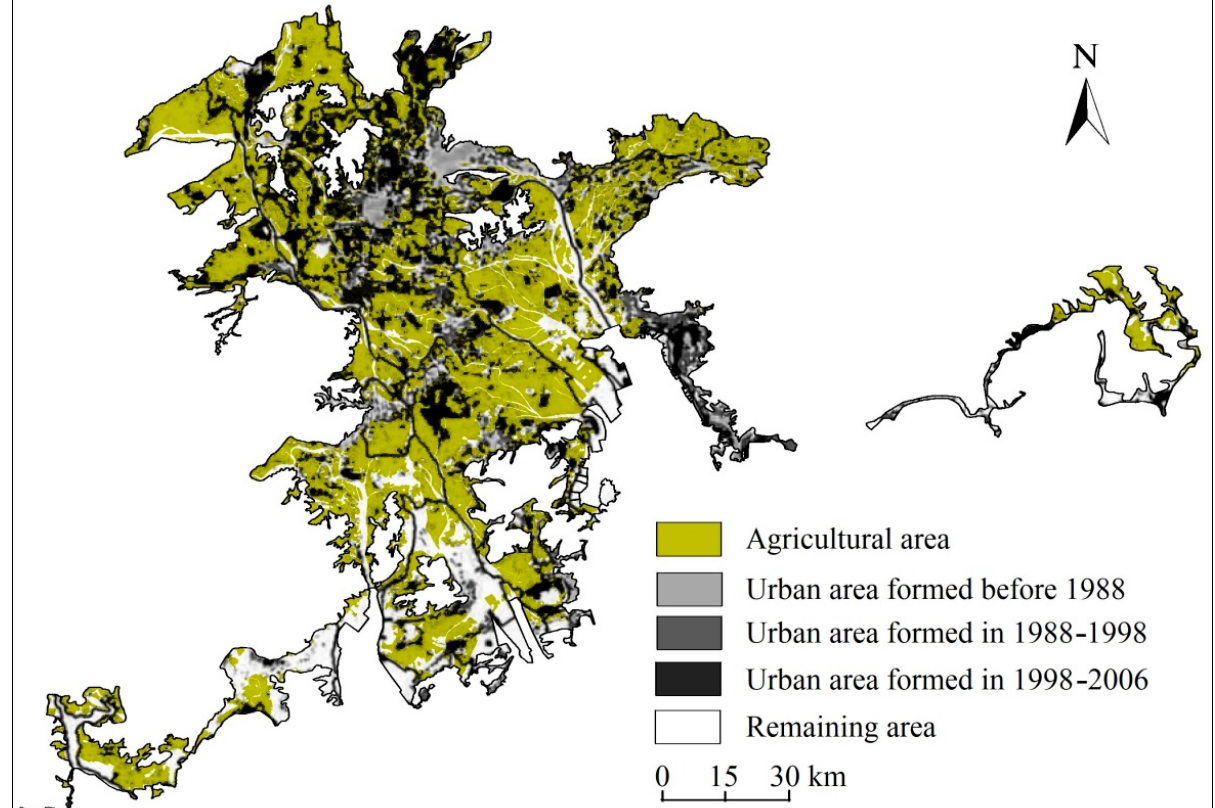
Figure 2. Spatial distribution of land-use types covering the coastal alluvial aquifer of the Pearl River Delta (data related to agricultural land and urbanized areas from [21] and [27], respectively).